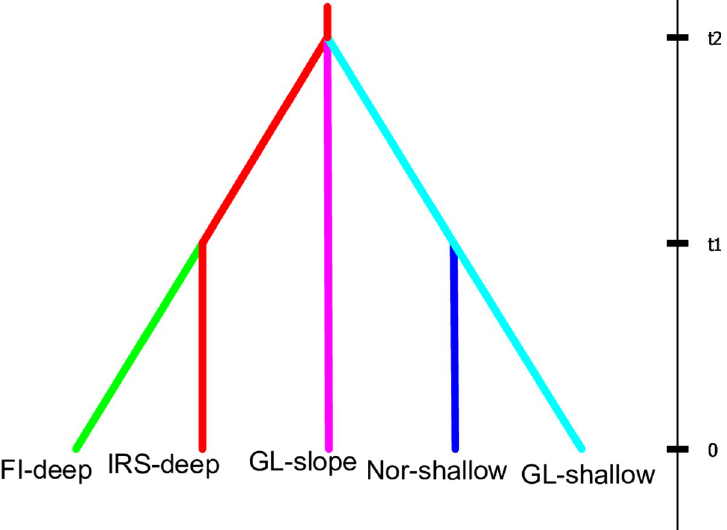
Fig 5. Results from the DIYABC analysis supporting a concurrent split among the ‘shallow’, ‘deep’ and ‘slope’ ecotypes. Subsequent splits were estimated within the ‘shallow’ and ‘deep’ ecotypes (for details see S1 File).